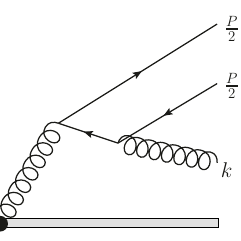
or 1 S [8] Q (cid:22) Q at LO in 0 0